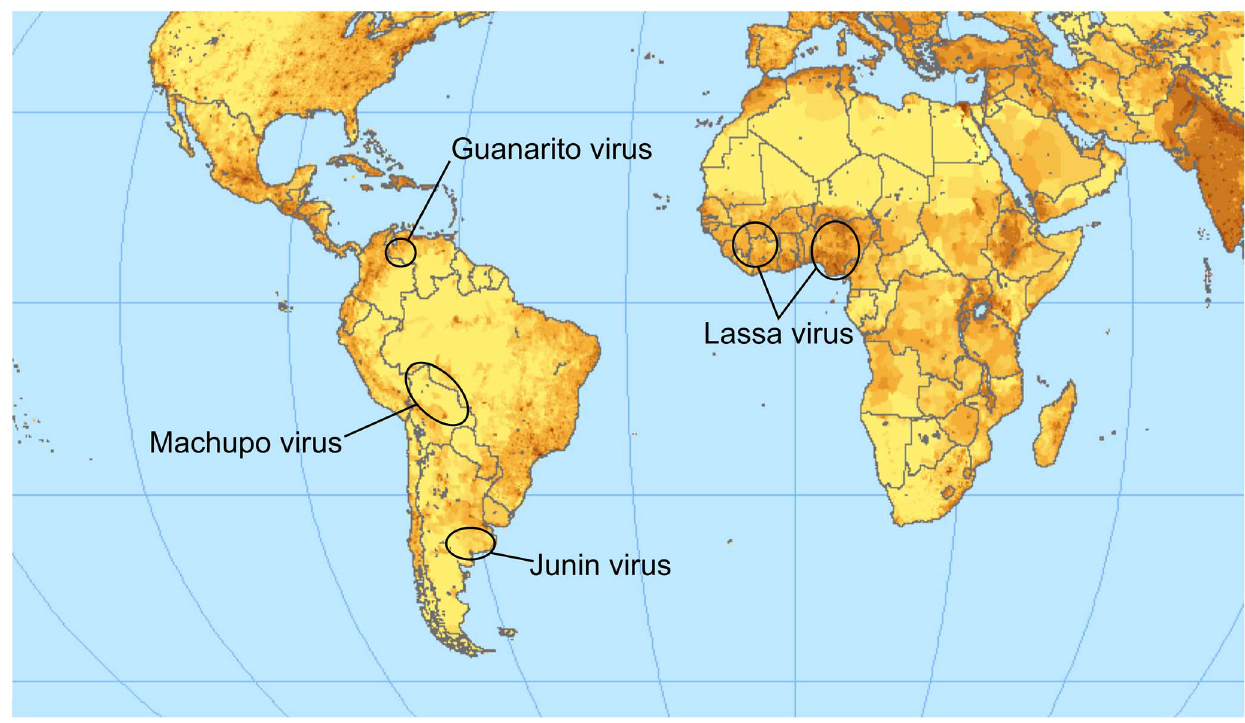
Figure 1. Endemic regions for the pathogenic arenaviruses mentioned in the text. The color intensity indicates the population density. Lassa virus is clearly endemic in the most populated region of Africa; a vaccine is therefore of high relevance for public health. The map is available under a Creative Commons license (http://www.flickr.com/photos/54545503@N04/5485517485/sizes/o/in/photostream/).